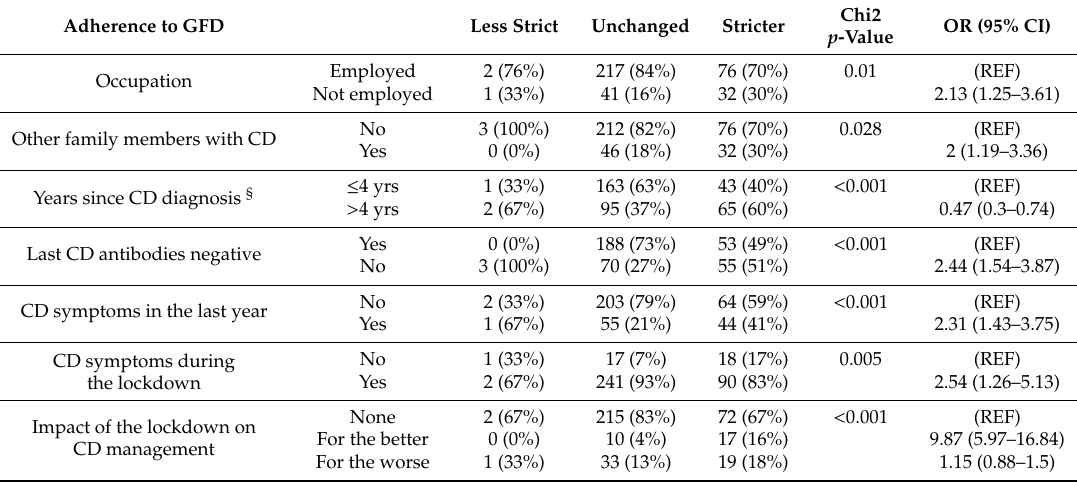
Table 6. Factors influencing the adherence to GFD during the lockdown, as reported by parents / caregivers of children with